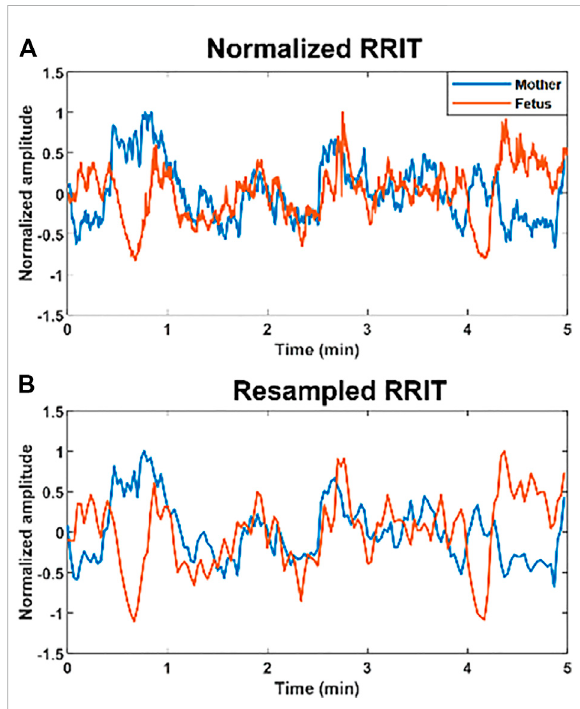
FIGURE 1 Example of normalized and resampled maternal and fetal RR interval tachograms (RRITs). (A) The fi gure shows an example of maternal (blue) and fetal (orange) RRITs before resampling, the amplitudesarenormalizedinthis fi gurebyusingEq.1. (B) The fi gure shows resampled RRITs, resampling was done by taking the average of RRI per 2